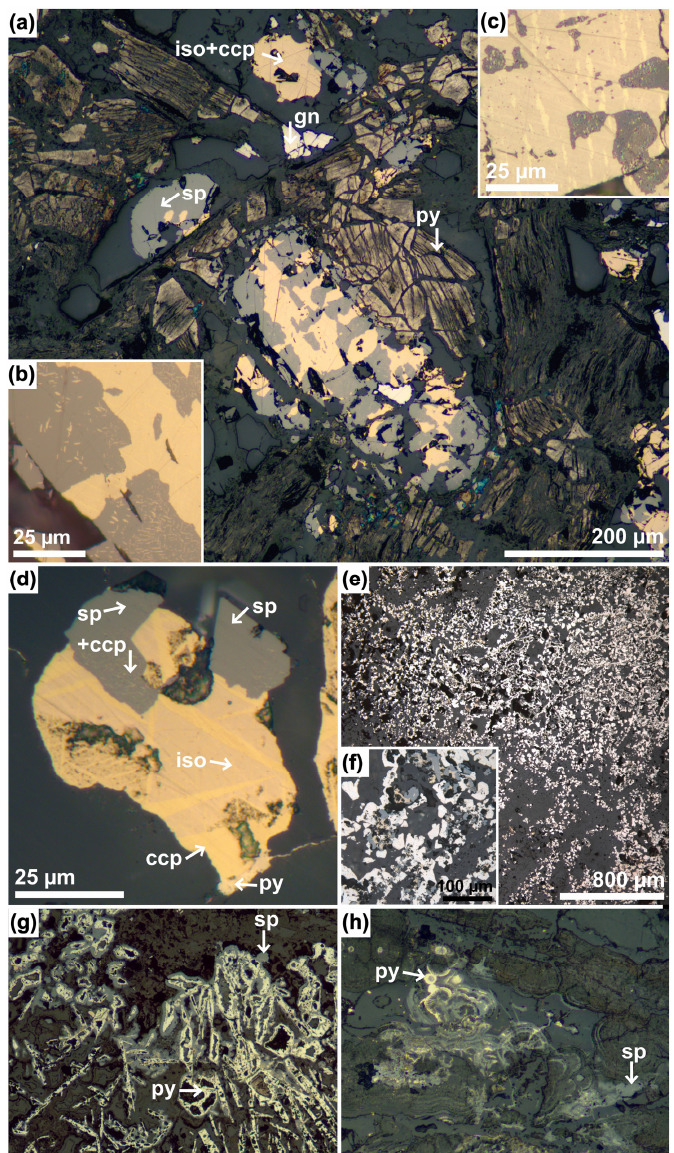
Figure 5. Examples of sulphide phases under reflected light. Mineral abbreviations after [43]. iso is isocubanite. ( a ) Overall mineral composition of a high-grade example of mineralised material, with dark grey gangue, mid-grey sphalerite, yellow/pink isocubanite and chalcopyrite, white galena and highly altered pyrite laths (sample viii ); ( b ) Sphalerite (grey) is variably clean or affected by sub-micron scale chalcopyrite disease (yellow) (sample viii ); ( c ) Typical isocubanite (pink yellow) grain containing micron-scale blebs of crystallographically controlled chalcopyrite exsolution lamellae (yellow) and grains of sphalerite (grey, variably exhibiting chalcopyrite disease) (sample ii ); ( d ) Grain of isocubanite with exsolution lamellae of chalcopyrite in two crystallographic orientations, degraded chalcopyrite-bearing patches and variably clean sphalerite (sample xi ). Localised pyrite occurs in the assemblage; ( e , f ) Mineralogy of sulphide lenses (grey sphalerite, yellow chalcopyrite/isocubanite, white pyrite/marcasite) in black material (sample iv(b) ); ( g ) Boxwork-like and ( h ) colloform pyrite with sphalerite from sample i